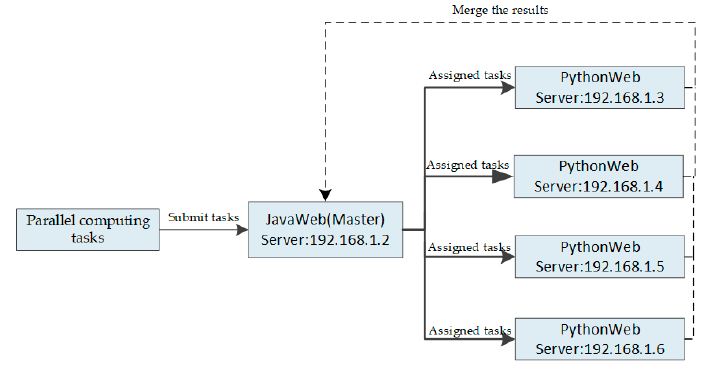
Figure 2. Microservices architecture used in this paper.